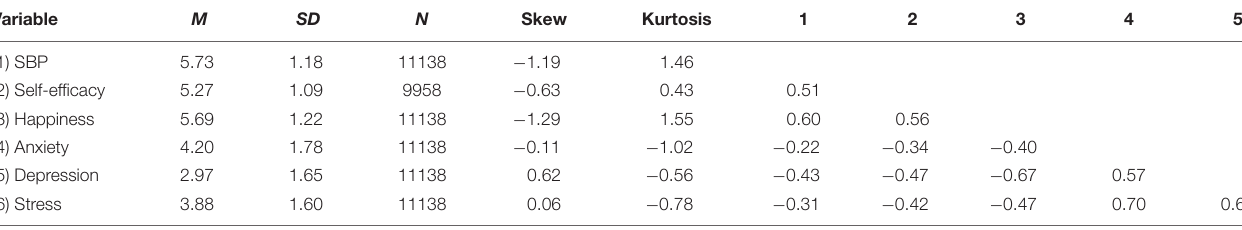
TABLE 1 | Descriptive statistics and zero-order correlations of observed variables. Variable